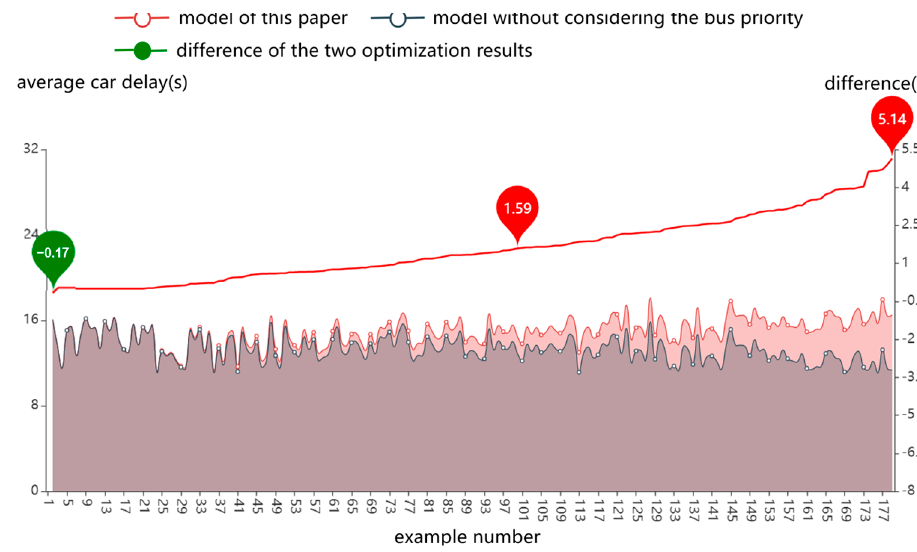
Figure 15. Comparison of the average car delay after the optimization of the two models.